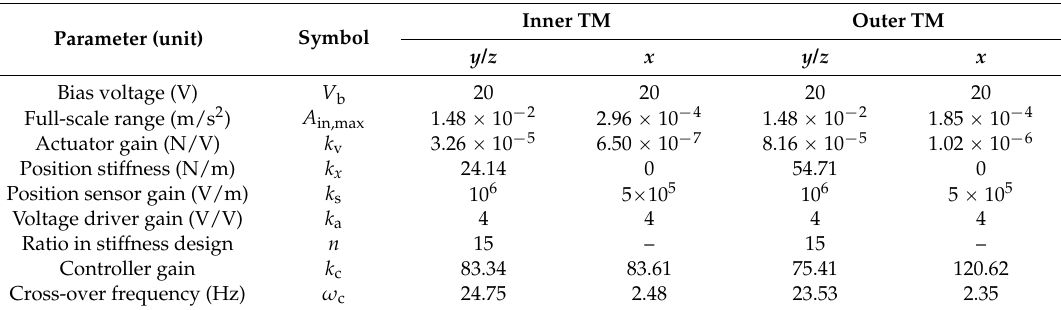
Table 4. Parameters of the electrostatic suspension loops.